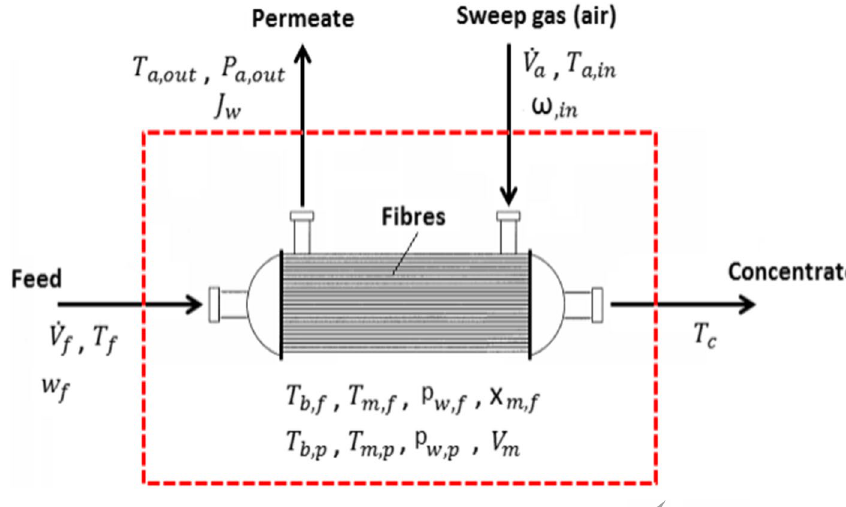
Fig. 8 The functional param- eters of